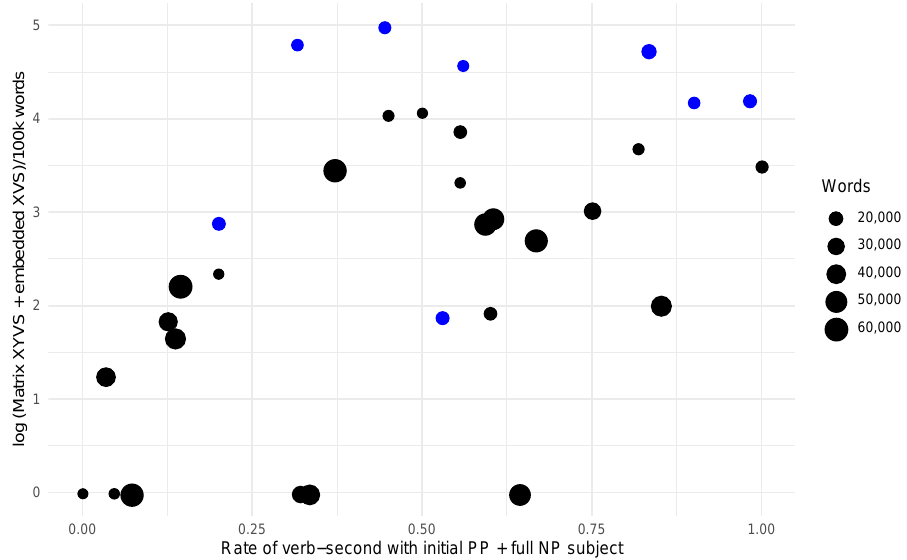
Figure 6. Correlation of the CM orders with inversion in PP‑initial matrix clauses with full NP sub‑ jects, 14th–15th‑century texts of >10,000 words. The major northern texts are highlighted in